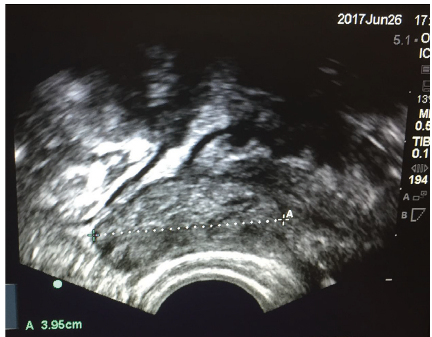
Figure 2: Mass in the pouch of Douglas.